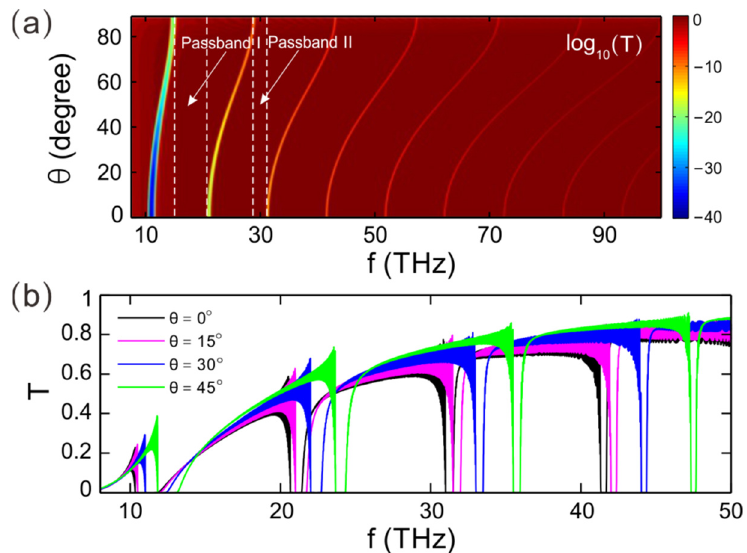
Figure 7. ( a ) Transmittance in the parameter space composed of the incident angle and the light frequency. ( b ) Transmission spectra for different fixed incident angles. The spatial distance is d 2 = 10 μ m, the graphene chemical potential is μ = 0.4 eV, and the relaxation time is set as τ = 0.5 ps.